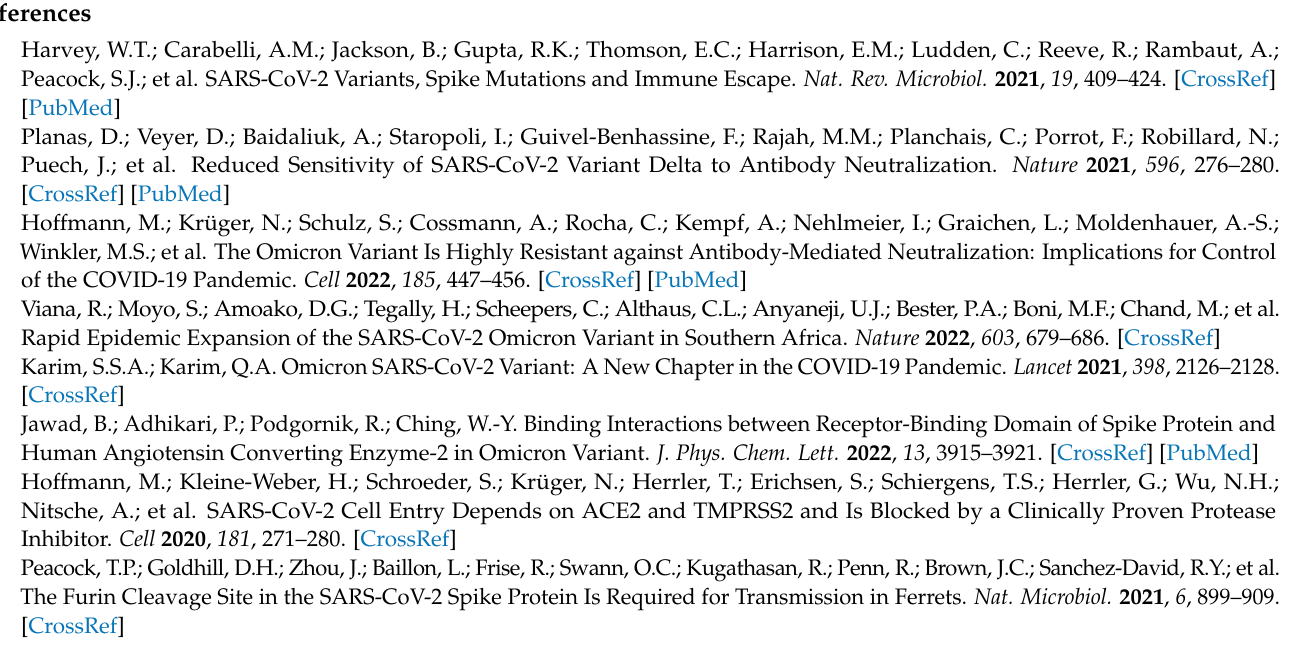
machine learning; Figure S1. Ball and stick figures of SD2-FP and HR1-CH showing the two cleavage sites marked in magenta, and Omicron variants mutations in the region of SD2-FP and HR1-CH are marked in green and orange, respectively. Red: O, blue: N, grey: C, white: H, yellow: S, Figure S2. Changes in intramolecular shape and size of specific mutations in the Omicron variant. Surface figures in different orientations for N856K in (a) and (a (cid:48) ), Q954H in (b) and (b (cid:48) ), N764K in (c) and (c (cid:48) ) and D796Y in (d) and (d (cid:48) ). The WT is on the left, while the OV is on the right. The surface of mutated sites is shown in magenta, the surfaces of NN and NL are shown in yellow and green, respectively. All NN and NL AAs are marked near to their surface in brown and black, respectively, Figure S3. Total density of states (TDOS) of the (a) SD2-FP model and (b) the HR1-CH model for both WT and OV, Figure S4. Partial density of states (PDOS) of the WT and OV amino acids for six sites of (a) SD2-FP model, and four sites of (b) HR1-CH model; Table S1. Data notation in machine-readable format for ML based on Table 1. The last digit is “0” for WT and “1” for the mutated type, Table S2. Machine-readable data notation in ML for the RBD-SD1 OV model. The last digit is “0” for WT and “1” for the mutated